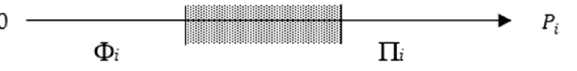
Figure 4. Pruning